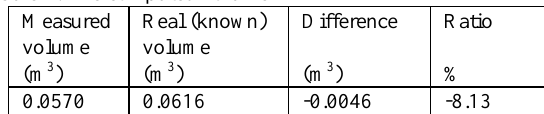
Table 2. The computed volume